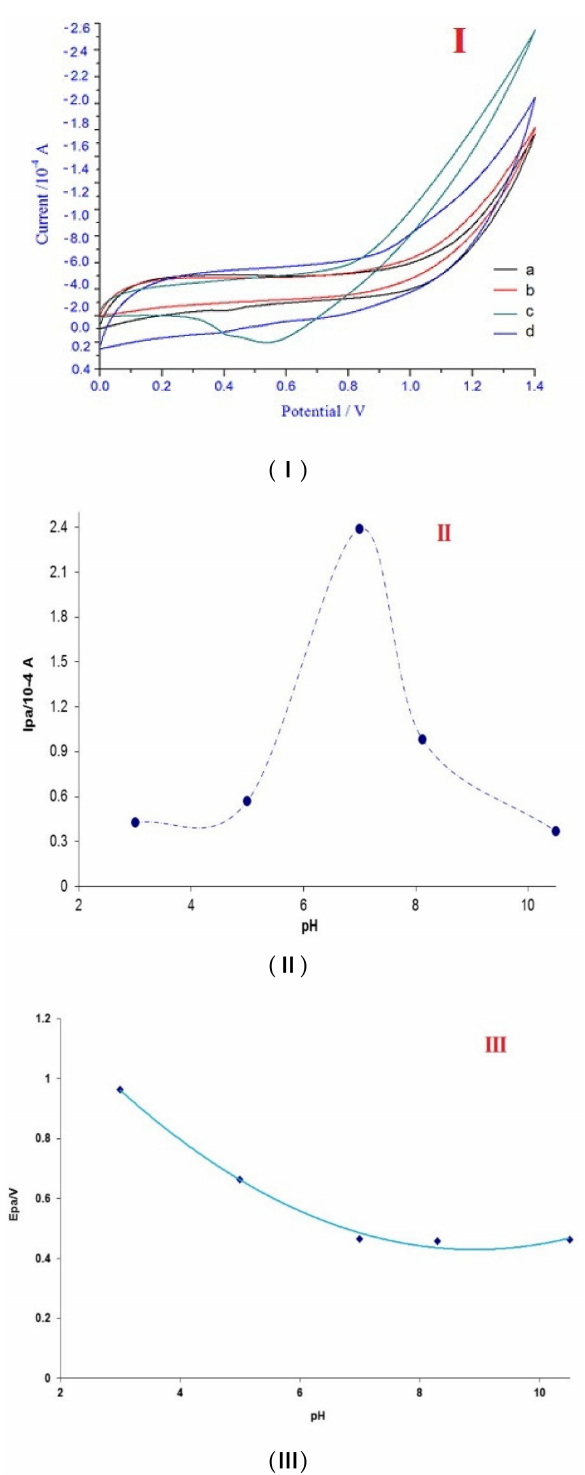
Figure 5. ( I ) Cyclic voltammograms at di ff erent pH on the shape of the anodic peaks in PBS solution at ( a ) 3.0, ( b ) 4.8, ( c )7.0 and ( d ) pH 10.4 at 50 mVs − 1 . ( II ) Variation of currents with pH on GCE at scan rate of 50 mVs − 1 in phosphate bu ff er ( III ) Influence of pH on the potential of AMT on GCE at a scan rate of 50 mVs − 1 in phosphate bu ff